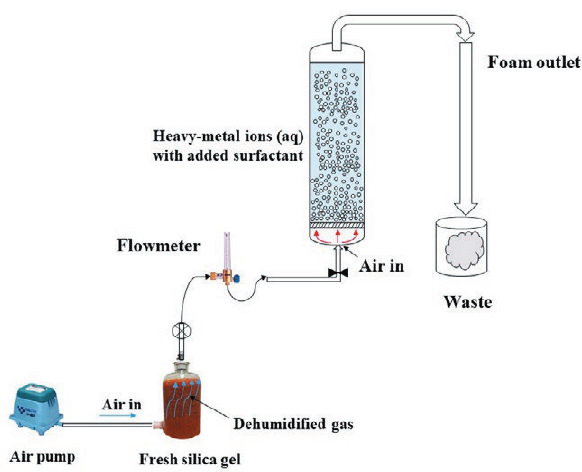
Figure 1. Schematic diagram of the column setup for ion flotation